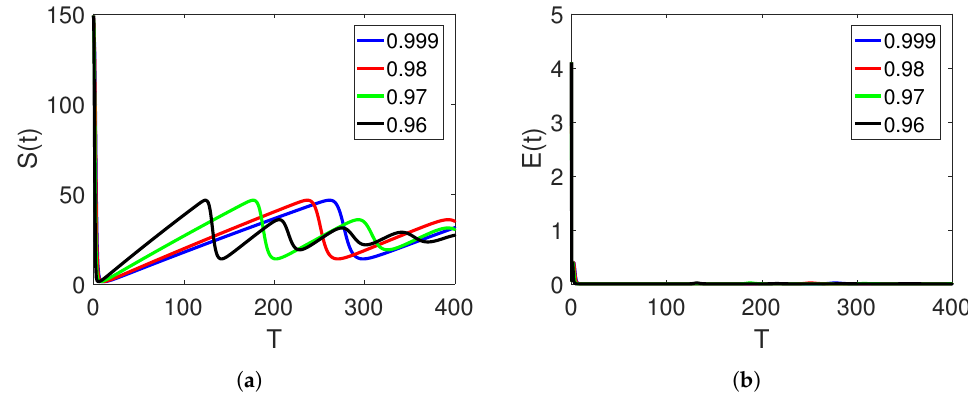
Figure 4. Dynamics of the susceptible class ( a ) and exposed class ( b ) on different arbitrary fractional order ς on sub interval [ 0, t 1 ] and [ t 1 , T ] of [ 0, T ] for different time